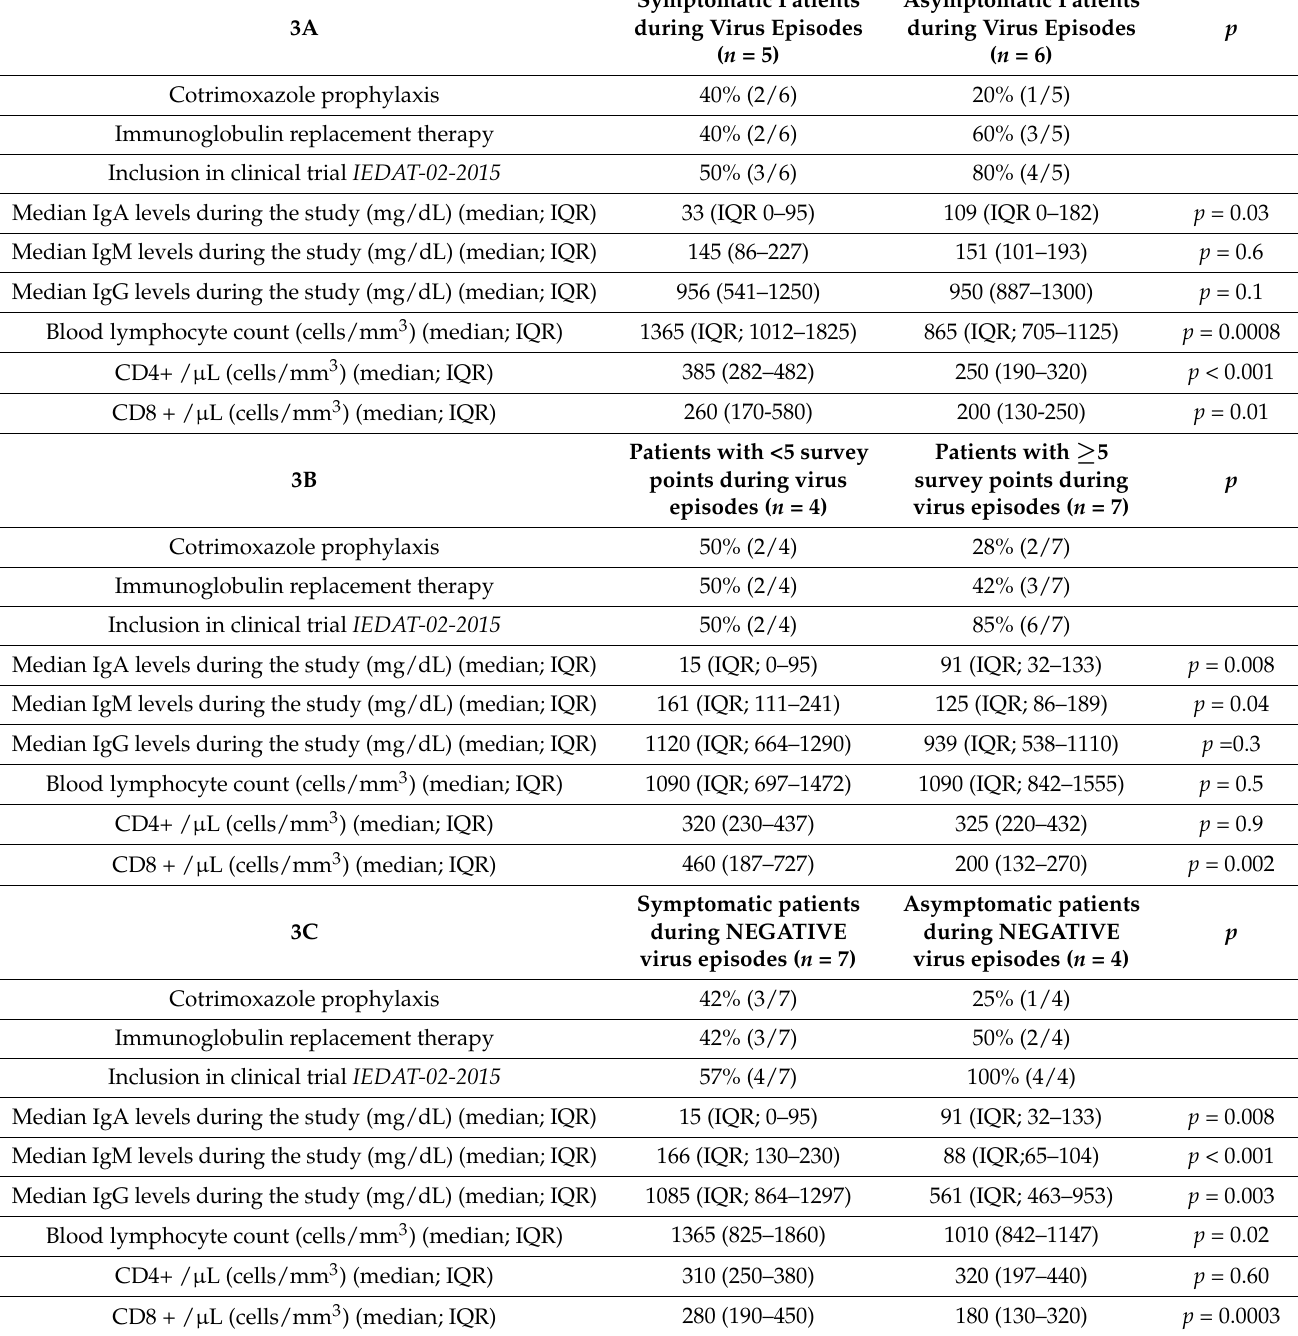
Table 3. ( A ) Comparison between symptomatic and asymptomatic patients during positive virus episodes; ( B ) between patients with and without moderate/severe symptoms during positive virus episodes; ( C ) between symptomatic and asymptomatic patients during negative virus